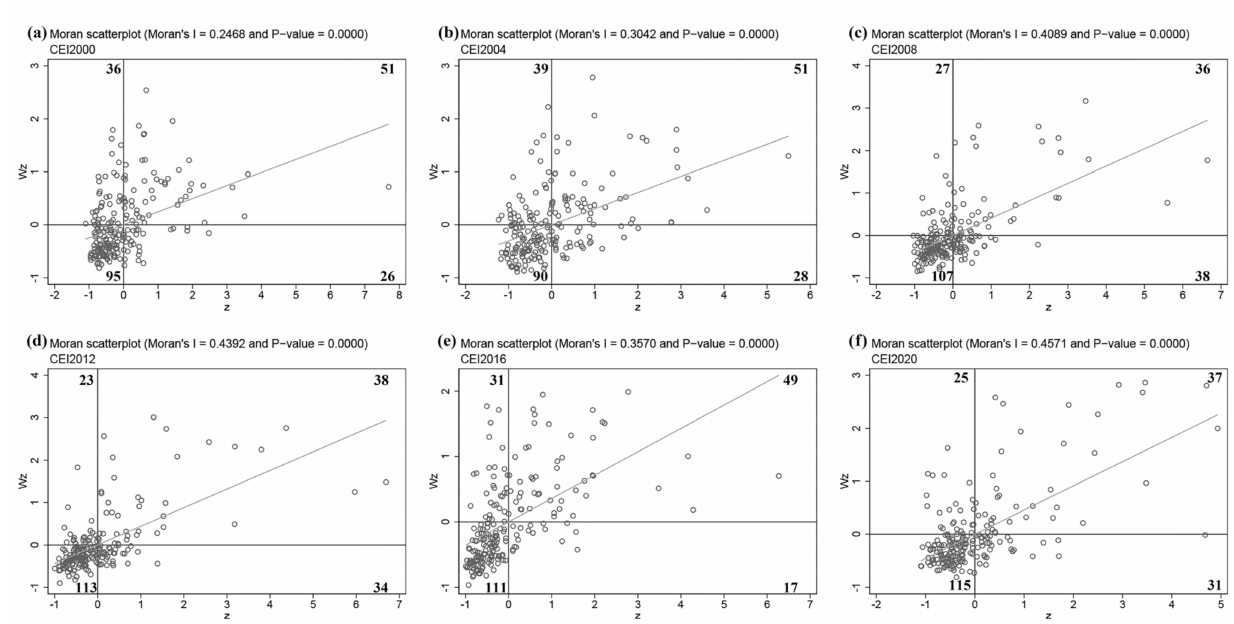
Figure 5. Moran scatter plot of carbon emission intensity at the county level in Northeast